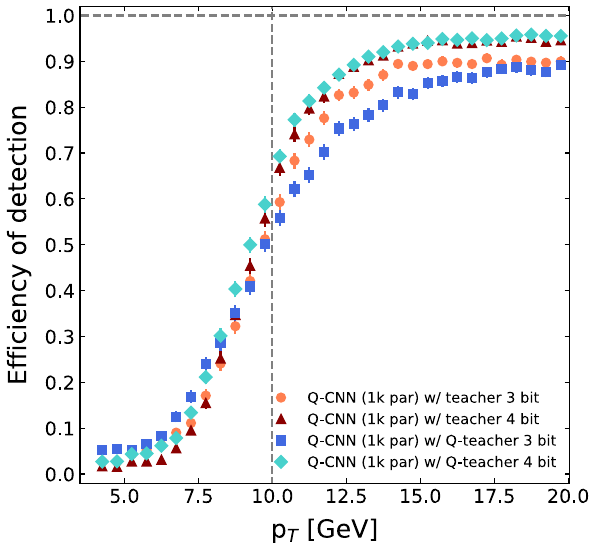
Fig. 13 Plateau Efficiency computed as the mean efficiency in a true p T interval well above threshold ( p T > 17 GeV) as a function of the number of bits per weight. In indigo (circles) the performance of the Teacher model. In light green (triangles) the performance of the Student trained without any help from the Teacher. In red (squares) the performance of the Student trained with hints from the